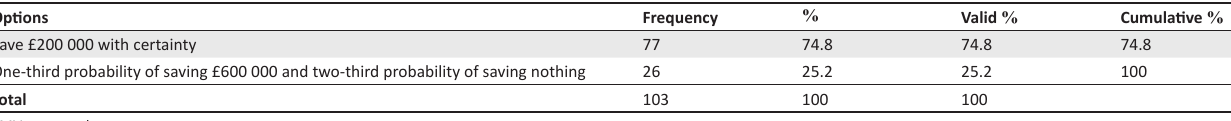
TABLE 3: EMV when options are in terms of gains or frequencies. Options